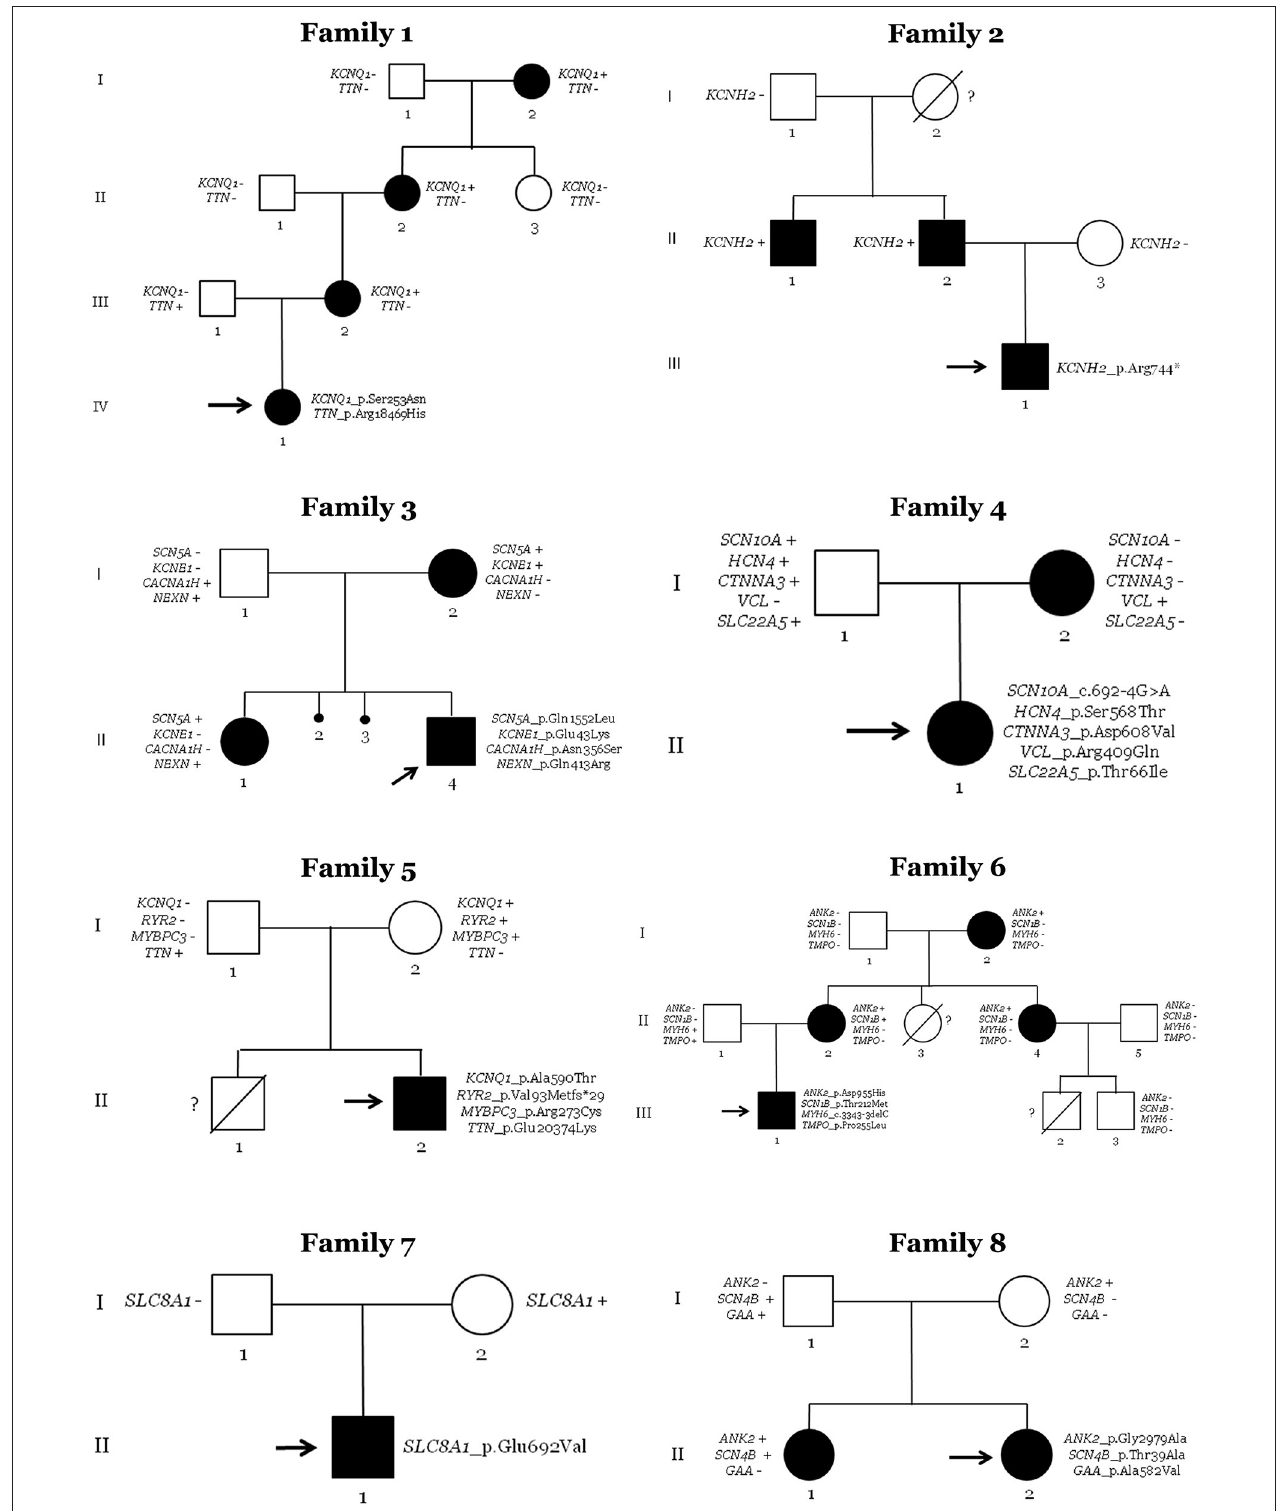
FIGURE 3 | Pedigrees of families. Generations are indicated on the left side. Each individual of direct family lineage is identified with a number. Definite patients diagnosed with Long QT syndrome are shown in black, clinically unaffected patients are in white, and slashes indicate a deceased relative. Index case is indicated with an arrow. Sign plus indicates carrier of the genetic variant. Minus sign indicates not carrier of the genetic variant. Interrogative sign indicates no genetic analysis available.